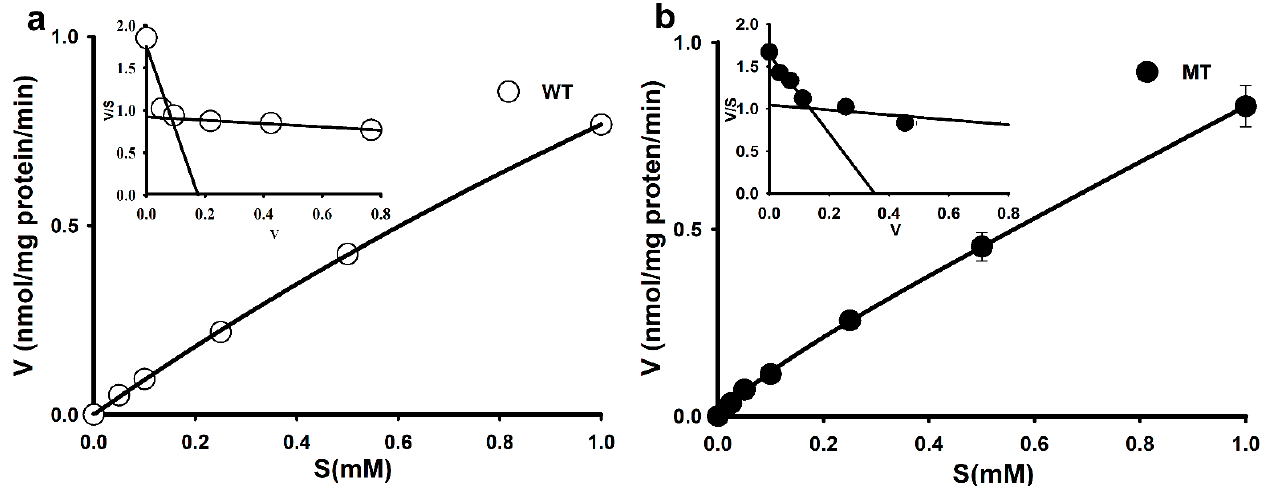
Figure 1. Concentration-dependent [ 3 H]L-arginine uptake in ALS cell lines. ( a ) Saturation kinetics of [ 3 H]L-arginine in the WT cell line. ( b ) Saturation kinetics of [ 3 H]L-arginine in the MT cell line. Uptake was measured after incubation for 5 min at 37 °C and pH 7.4 in the presence or absence of 0–1 mM unlabeled L-arginine. Each point represents the mean ± SEM. ( n = 3–4). The inset graphs are presented as Eadie–Hofstee Scatchard plots.